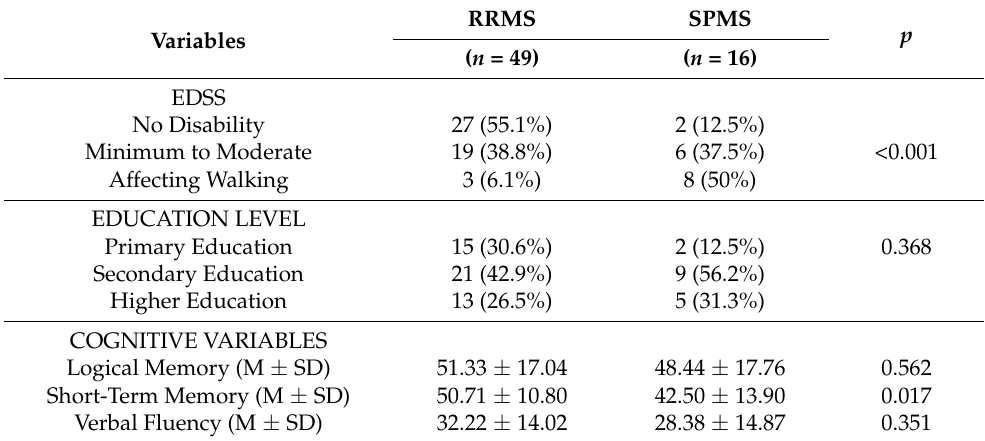
Table 4. Relationships between EDSS, educational level, cognitive variables, and type of